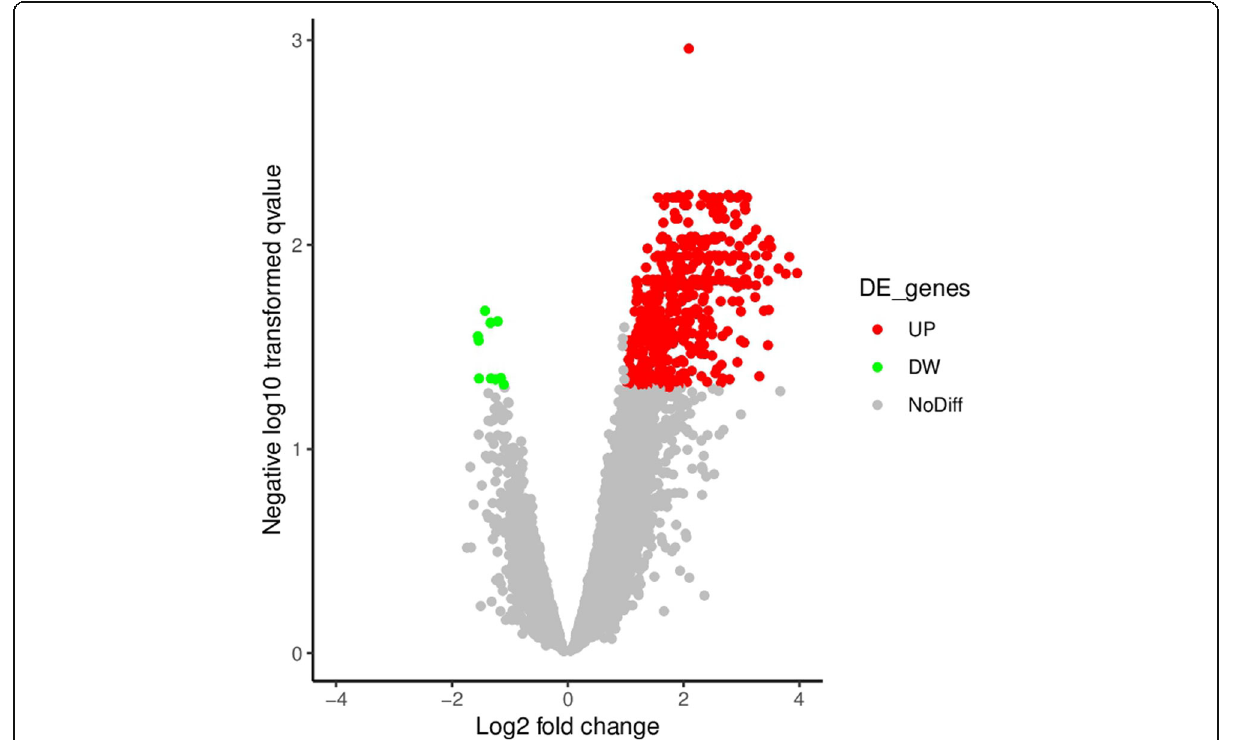
Fig. 1 Differentially expressed genes (DEGs) in